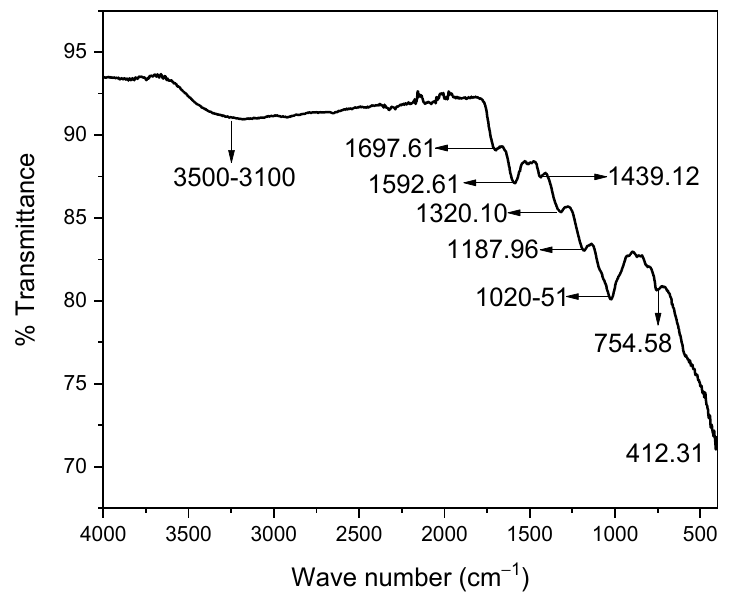
Figure 6. FTIR spectrum of Ag-CuO NC.